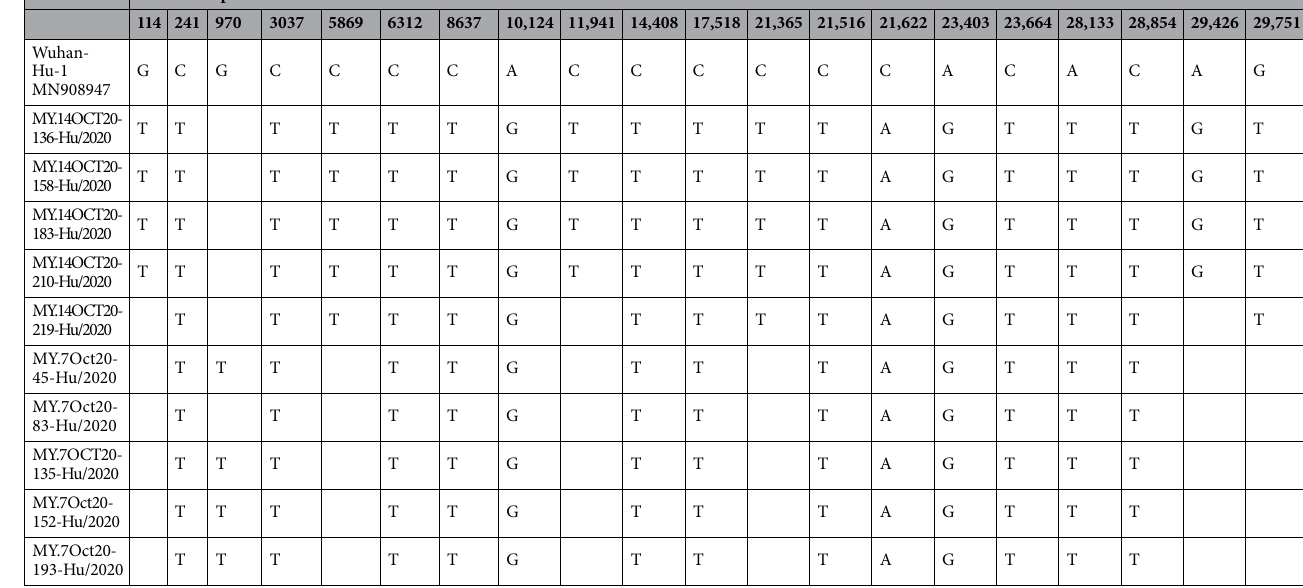
Two B(V) strains were detected in Malaysia on 31 March and 2 April 2020 (Fig. 1). In addition to the T11803, both strains possessed additional two nucleotide variations, C14805T and G26144T. The G11083T and G26144T were genetic markers for the assignment of GISAID Clade V. While the C14805T was an additional genetic trait present in this group. The C14805T was a synonymous mutation that was not originally present in China during the early spread of the virus, suggesting this mutation could have accumulated in the SARS-CoV-2 gene pool outside of China. These three linked mutations, however, were detected in strains detected in England and Korea beginning at the end of Jan and early Feb 2020, indicating the widespread distribution of the ancestor strains (https:// covid cg. org/). There was no B(V) strain detected in Malaysia after 2 April 2020. The B.6 (O)-associated lineage formed the largest group of Malaysia’s SARS-CoV-2 phylogenetic tree, com- prised of strains detected from 4 March to 4 June 2020. The SARS-CoV-2 strains sequenced in this study (21 April–2 May 2020) clustered within this subgroup. All B.6 strains within this group contained four additional genetic variations; C6312A, C13730T, C23929T, and C28311T in addition to G11083T mutation. These five mutations were probably linked mutations as these mutations were detected simultaneously in strains recov- ered from different countries in March 2020 (https:// bigd. big. ac. cn/ ncov/). These A6312A-T11083-T13730- T23929-T28311-bearing strains were segregated into multiple distinct subgroups with the presence of several unique genetic traits. Sequential accumulation of these mutations could have reflected the transmission path of SARS-CoV-2 in the local community. For example, the B.6.1(O) subgroup was also characterized by a mutation, T7621C. This T7621C mutation was a synonymous mutation detected in 29 strains, mainly from Malaysia and Brunei (https:// bigd. big. ac. cn/ ncov/ varia tion/ annot ation/ varia nt/ 7612), suggesting that this is a unique mutation that occurred in this region and could have originated from a single origin. These C7621-bearing strains were further delineated into two groups differentiated by an additional mutation, C25549T. Our samples obtained in mid-Apr 2020 clustered within the C7621-C2554T-groups, with additional mutations detected in some of the samples. Most of these samples were detected from individuals with travel histories to Indonesia and India. There was, however, no distinct spatial clustering of the samples. Samples’ collection time for the C25549-bearing and T25549-bearing groups, however, overlapped, indicating at least two independent and simultaneous transmission chains. Within B.6(O), another group with the additional mutation, C19524T, was observed; subsequently, an additional C6210A and then C2508A was detected in a subset of this group (B.6.6(O)). The B.6.6(O) comprised of samples linked to the identified Seri Petaling Gathering Cluster 41 . The T19524 and T19524T-A6210 strains were also detected in neighboring countries including Singapore, Thailand, and Australia (https:// bigd. big. ac. cn/ ncov/) but not the T19524-A6210-A2508 strains, suggesting the C2508A could be a mutation that accumulated in the SARS-CoV-2 gene pool during the second COVID-19 epidemic wave in Malaysia. Third COVID‑19 epidemic wave in Malaysia (from 8 October). Our phylogenetic results showed that all samples detected in Oct 2020 (Sabah and Selangor strains) clustered together within lineage B.1.524(G). Although these third epidemic wave strains clustered closely with strains detected in early April (hCoV-19/